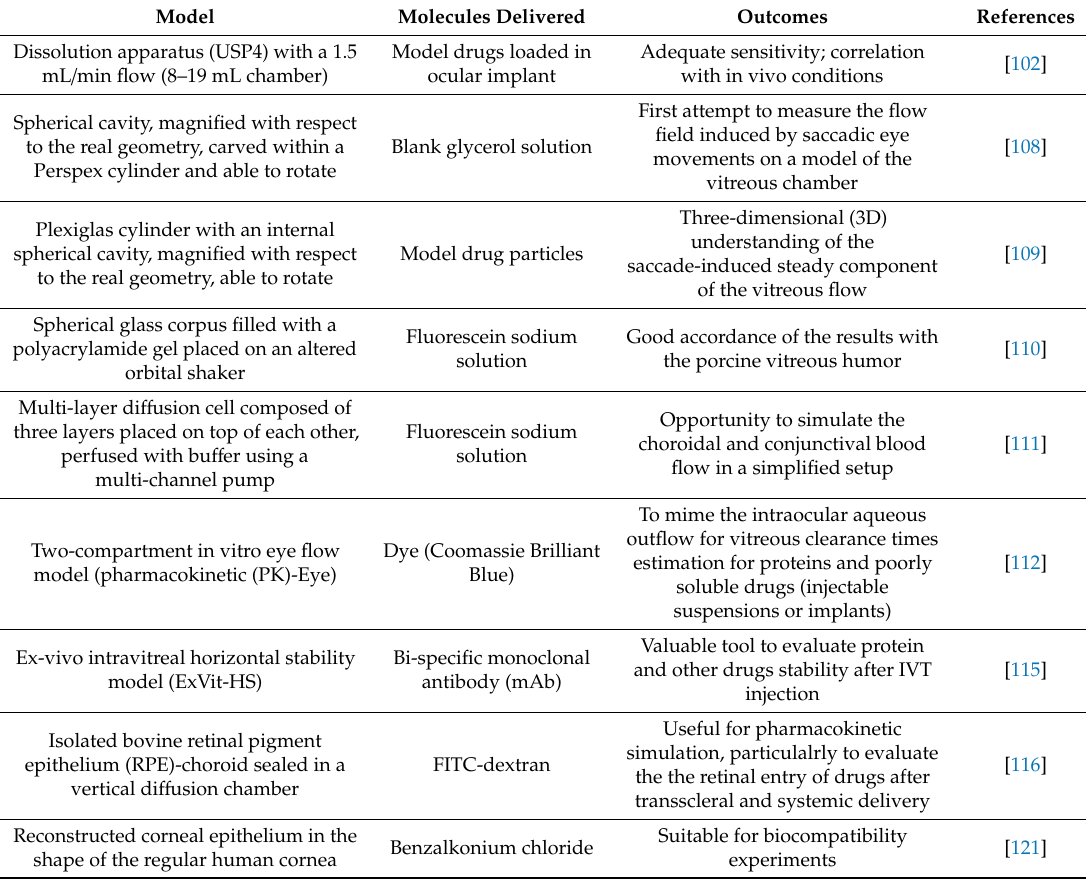
Table 3. In vitro ocular pharmacokinetic